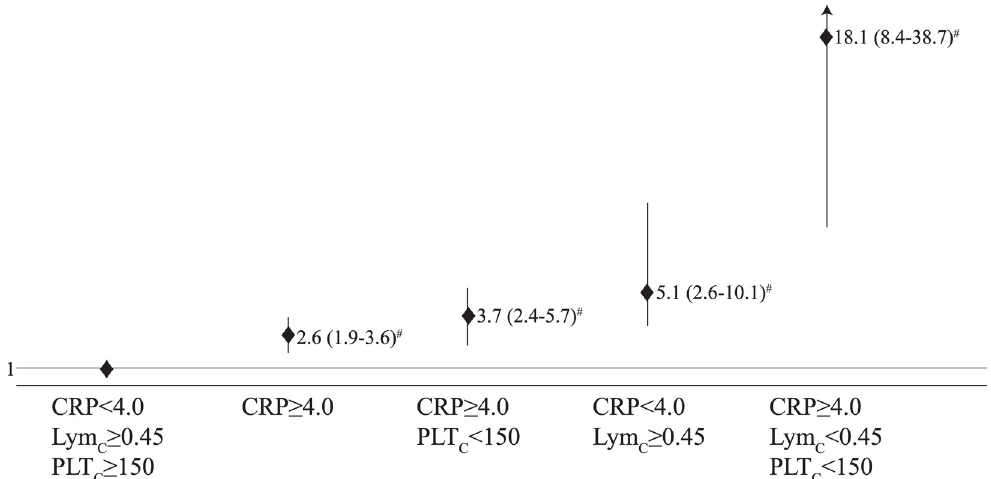
Fig 3. Combinations of CRP and hemogram parameters for likelihood of sepsis. Abbreviations: CRP, c-reactive protein; Eo C , eosinophil count; PLT C , platelet count. # , p < 0.001.